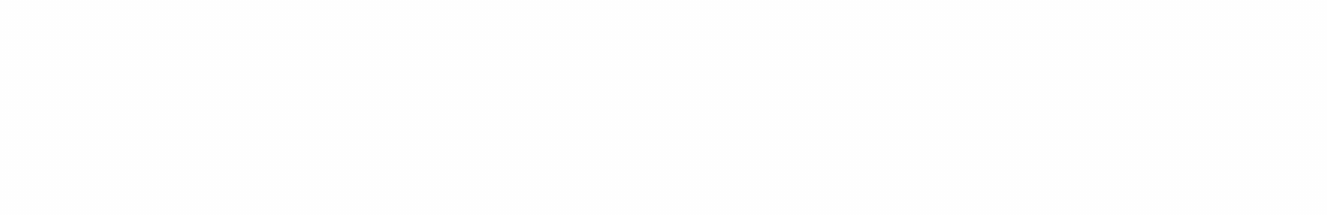
FIGURE 4 Welfare, environmental costs, and the "con- sumption" of value during an asymptotic process of popula- tion